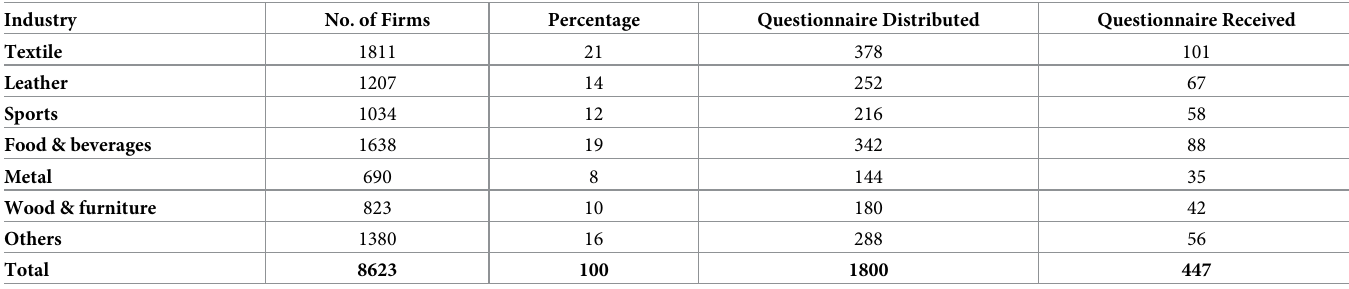
Table 1. Sample distribution by